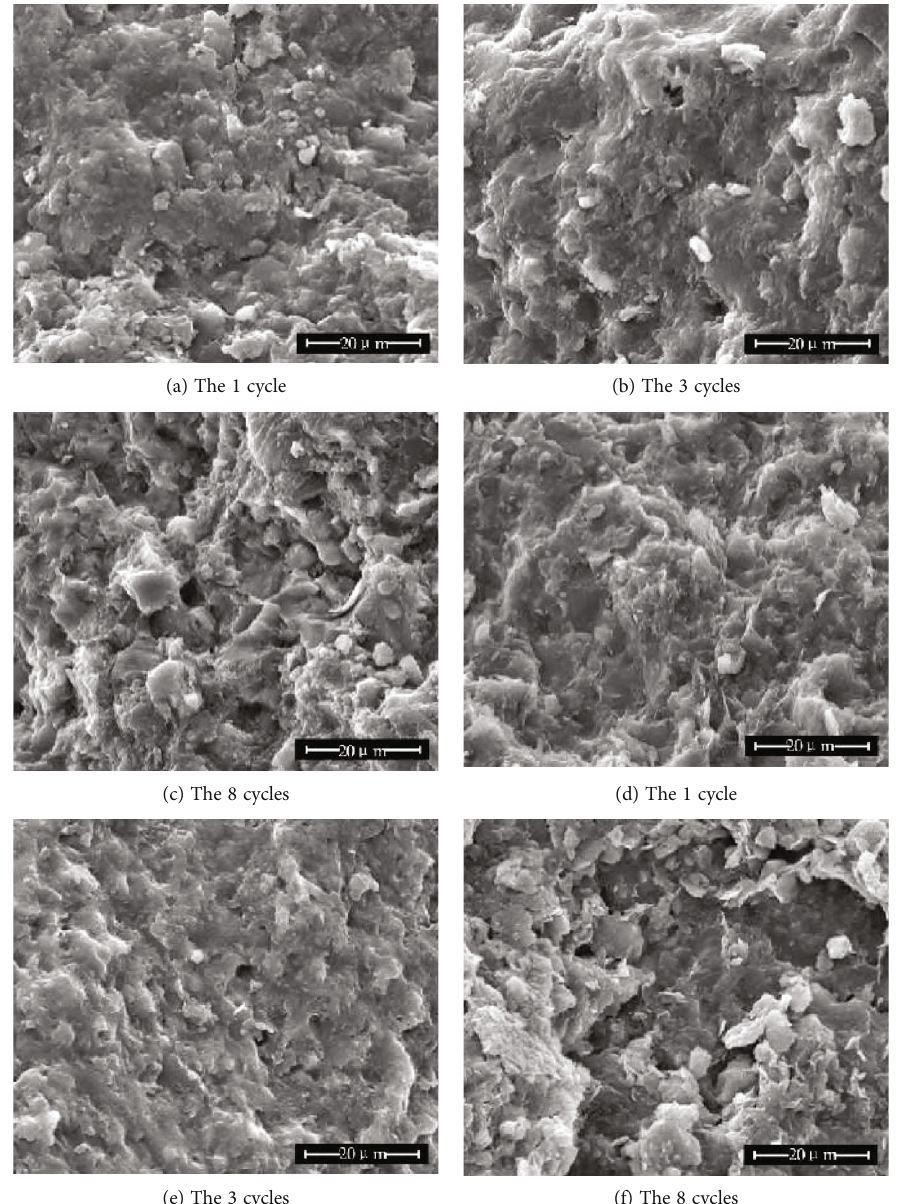
Figure 2: SEM test results of mudstone and sandstone under di ff erent water-rock coupling degrees (Tang et al.